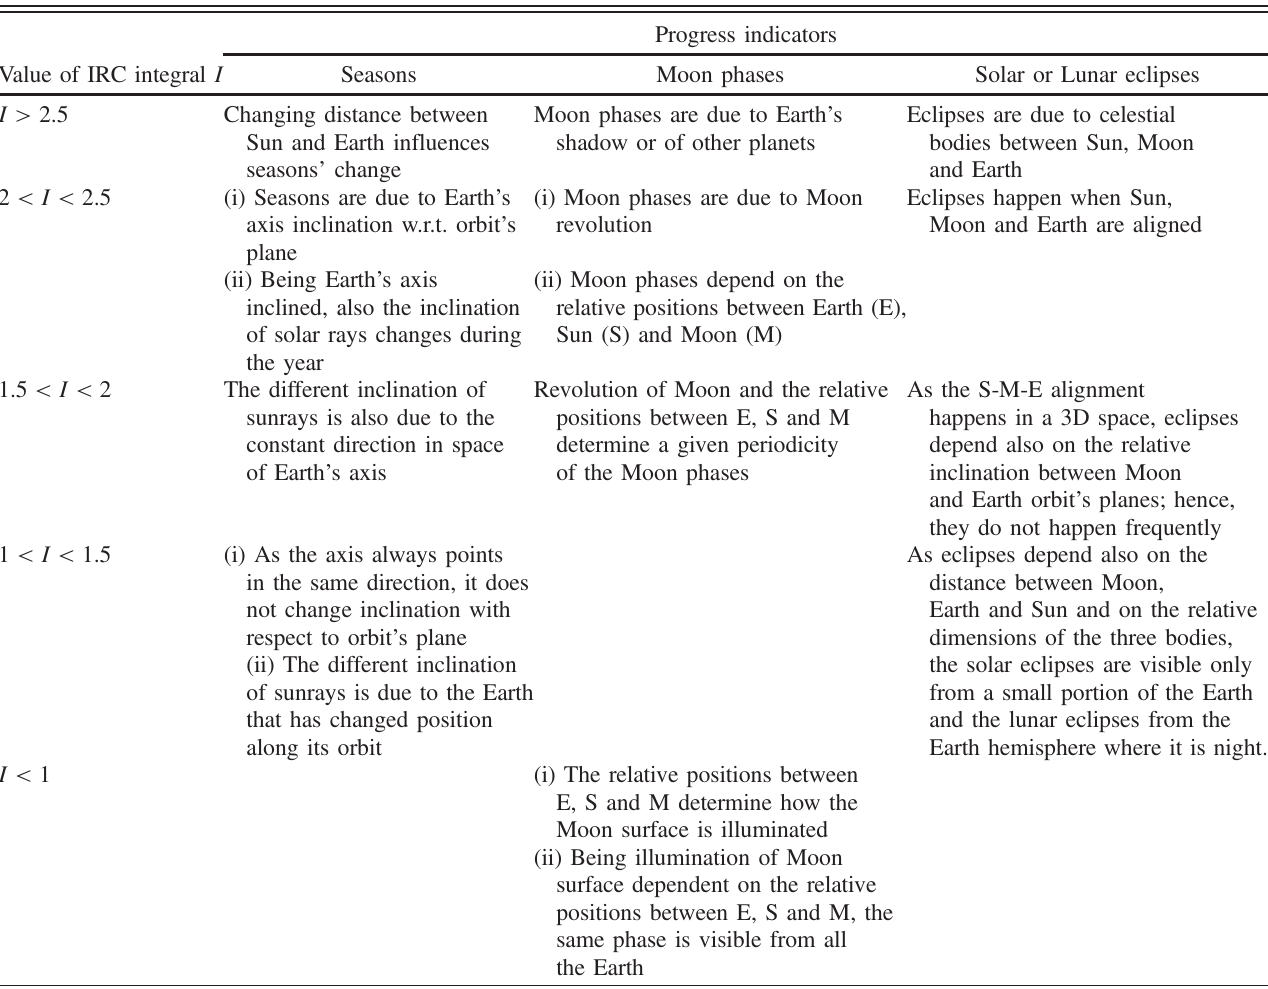
TABLE VI. Construction of the cluster levels for the seasons, Moon phases, and solar and lunar eclipses.